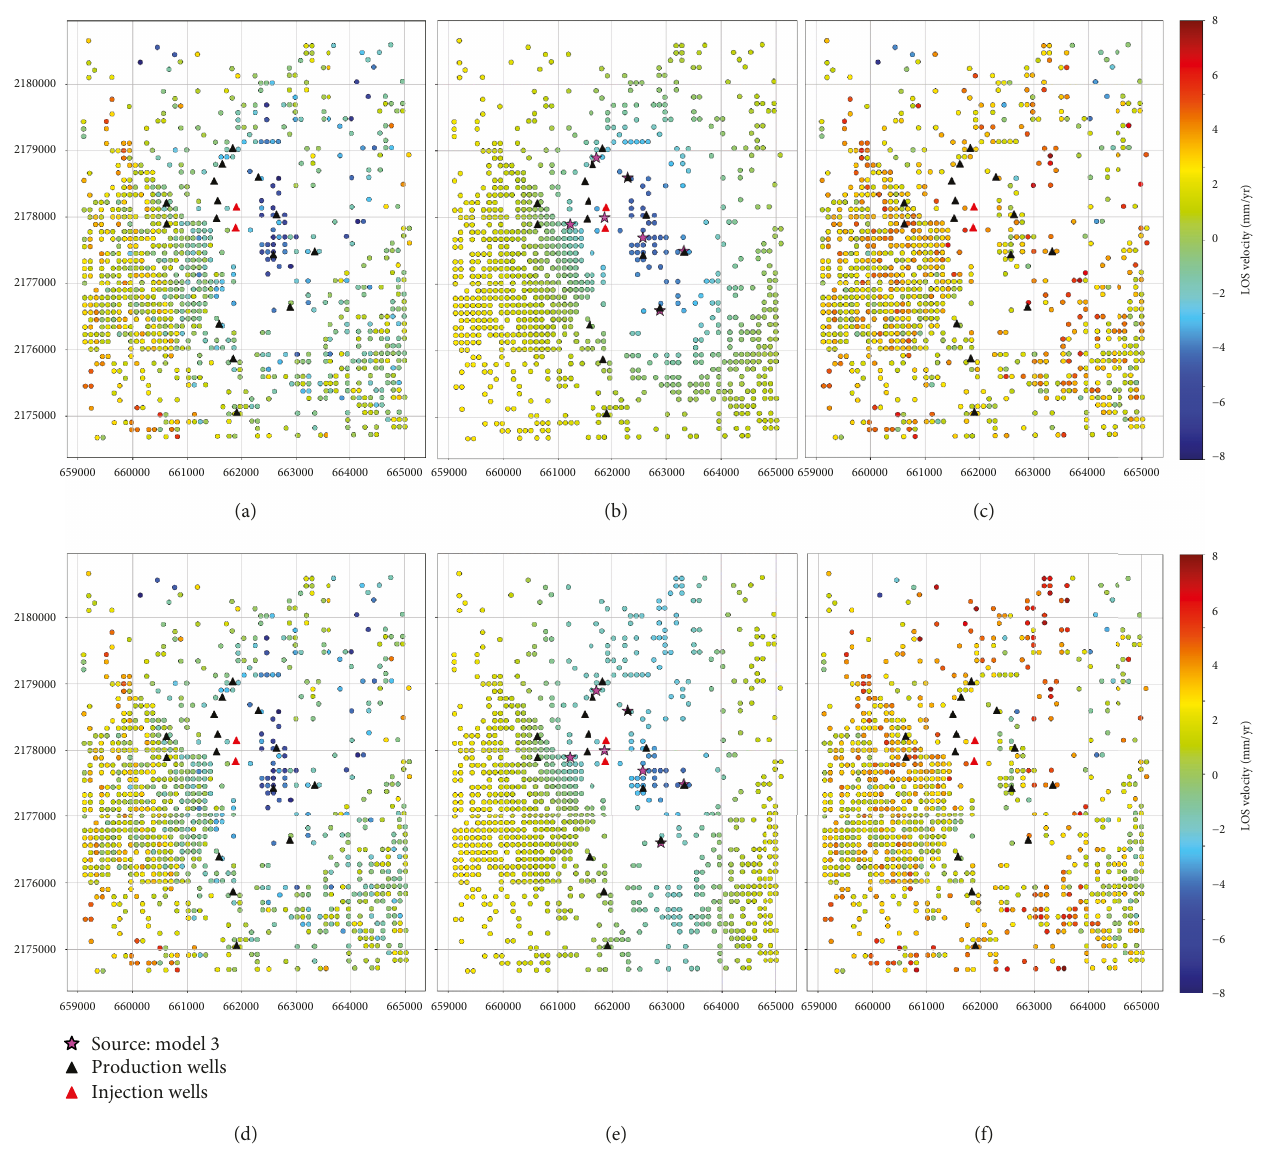
Figure 9: Observed (a, d), modeled (b, e), and residual (c, f) movements in the LOS direction in mm/yr. The coordinates are in UTM zone 14N. The outline of the modeled area is shown in Figure